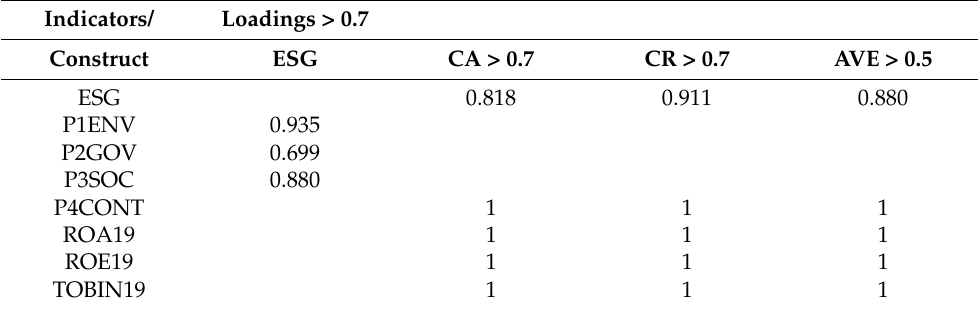
Table 2. Reliability and validity assessment.